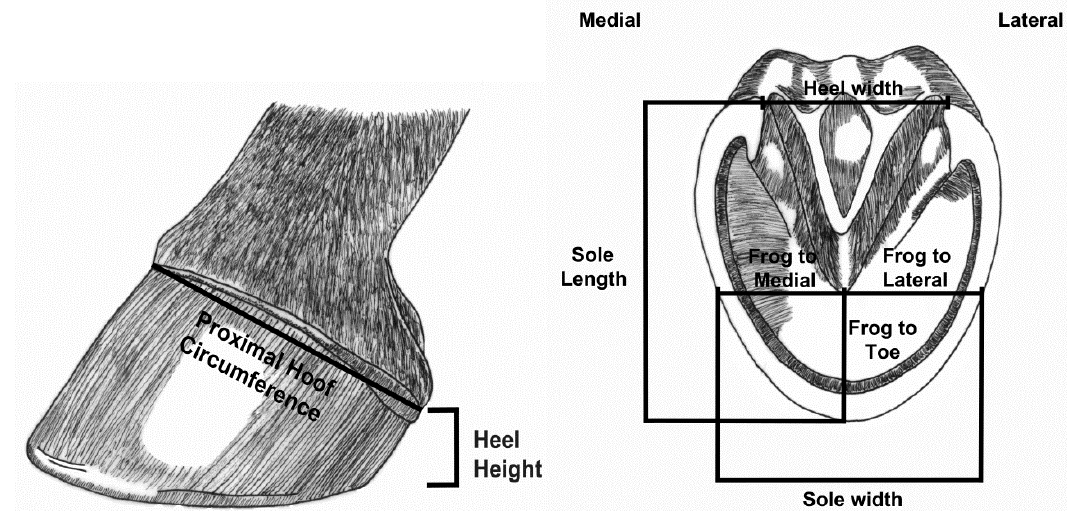
Figure 1. Measurements taken of the hoof.